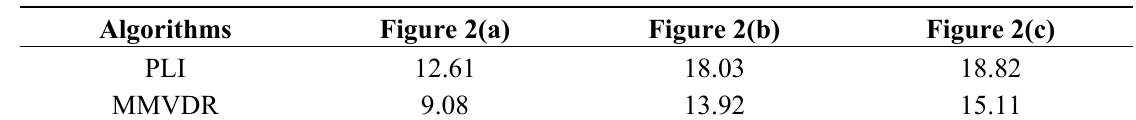
Table 2. Image errors